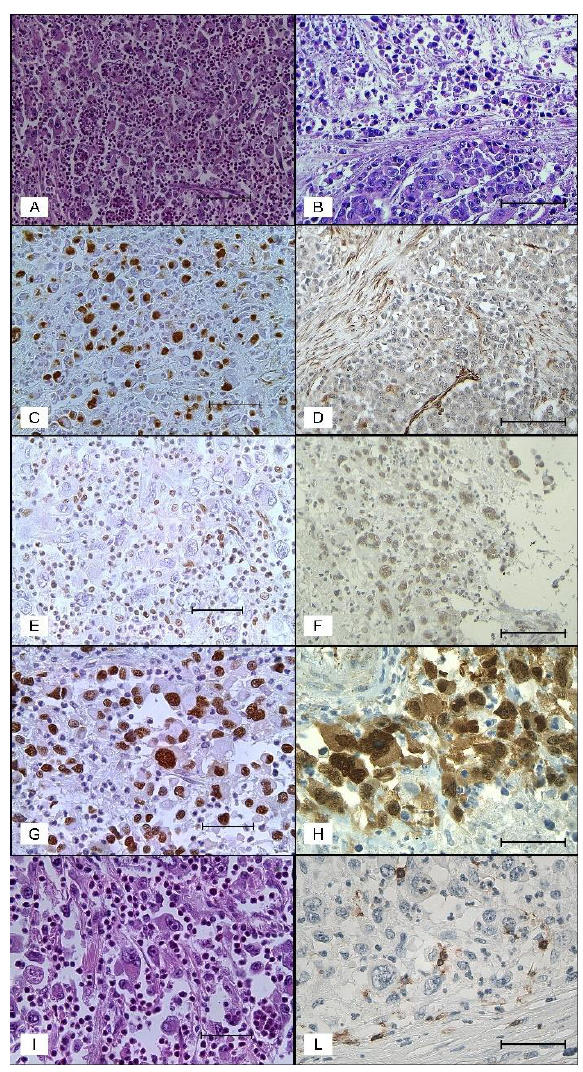
Figure 1. Morphological and immunohistochemical features in CRbCs and PDMCs. ( A ) and ( I ) CRbC showing non-cohesive rhabdoid cells admixed with numerous neutrophils (hematoxylin and eosin stain, 200× and 400×, scale bar 100 and 50 µm); ( B ) PDMC showing a cohesive medullary area adjoining an area of loosely cohesive cells (hematoxylin and eosin stain, 200×, scale bar 100 µm); ( C ) CrbC with strong immunostaining for vimentin predominantly in the paranuclear region of the cytoplasm (vimentin, 200×, scale bar 100 µm); ( D ) PDMC showing negative immunostaining for vimentin (vimentin, 200×, scale bar 100 µm); ( E ) complete loss of SMARCB1 (INI) expression) in a CRbC (INI-1, 400×, scale bar 50 µm); ( F ) loosely cohesive area of a PDMC showing SMARCB1 (INI) nuclear positivity (INI-1, 200×, scale bar 100 µm); ( G ) p53 nuclear expression in a CRbC (p53, 400×, scale bar 50 µm); ( H ) beta catenin nuclear expression in a CRbC (beta catenin, 400×, scale bar 50 µm); ( L ) CRbC showing few CD8-positive tumor infiltrating lymphocytes (CD8, 400×, scale bar 50 µm).